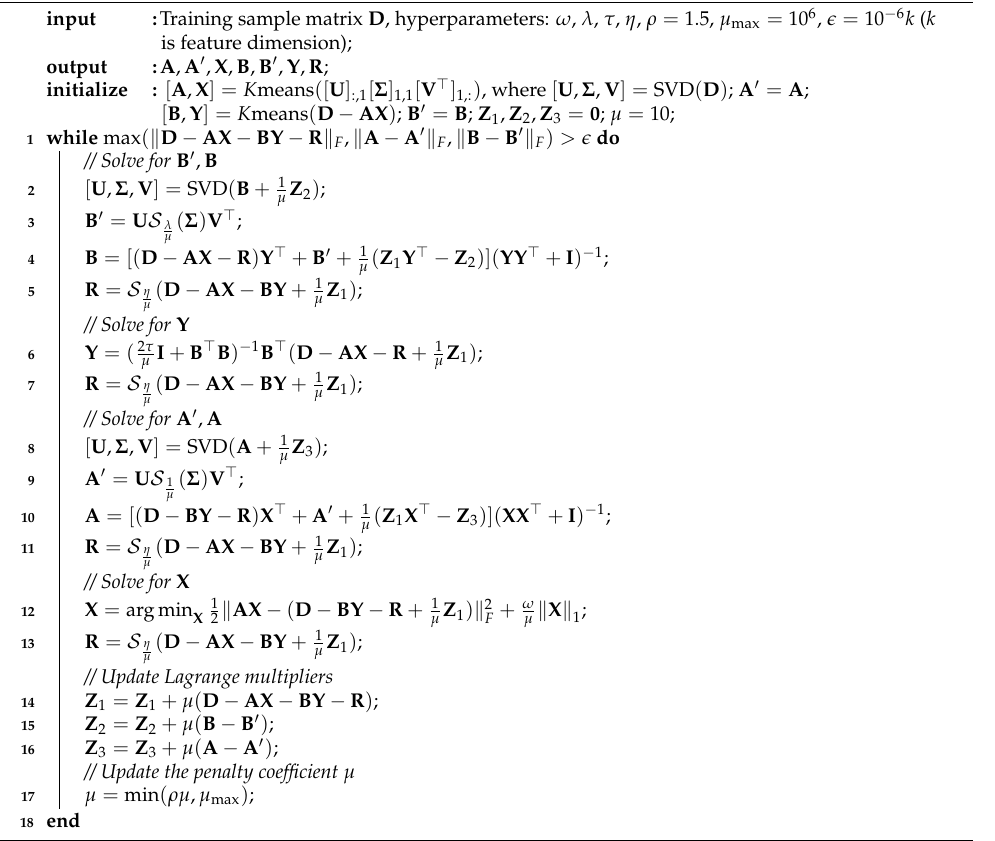
Algorithm A1: Algorithm for solving transformed SDD learning problem